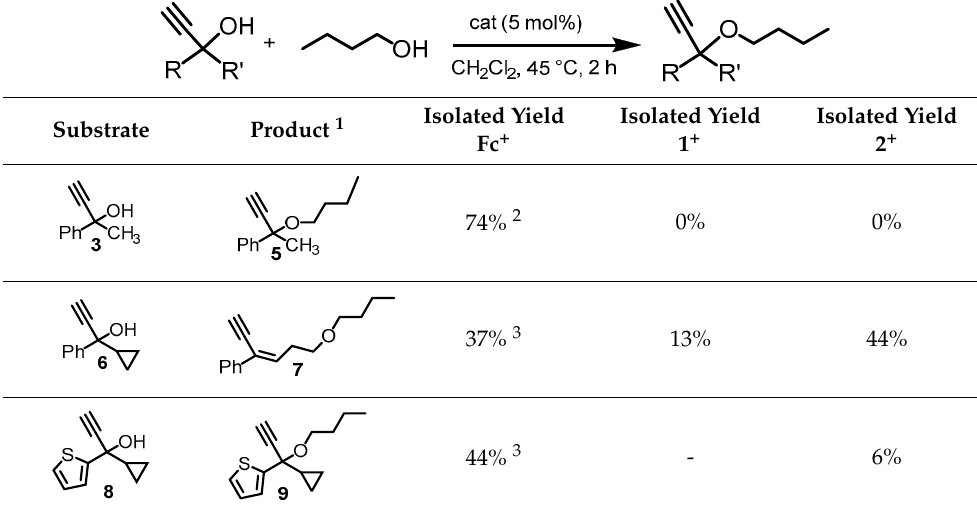
Table 5. Catalysis results.